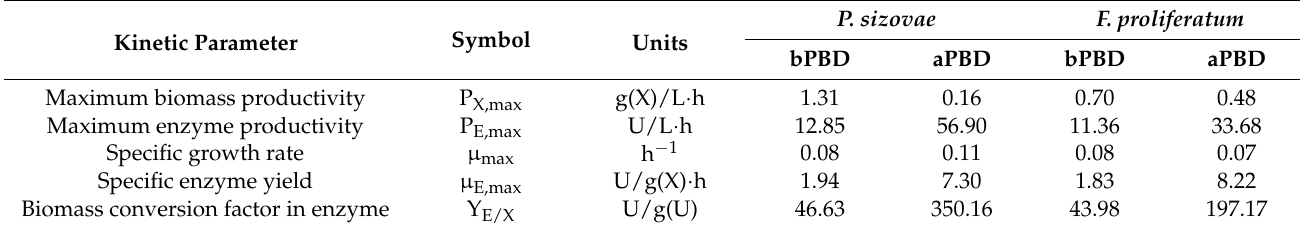
Table 5. Kinetic parameters of growth and L -asparaginase production by P. sizovae and F. proliferatum .